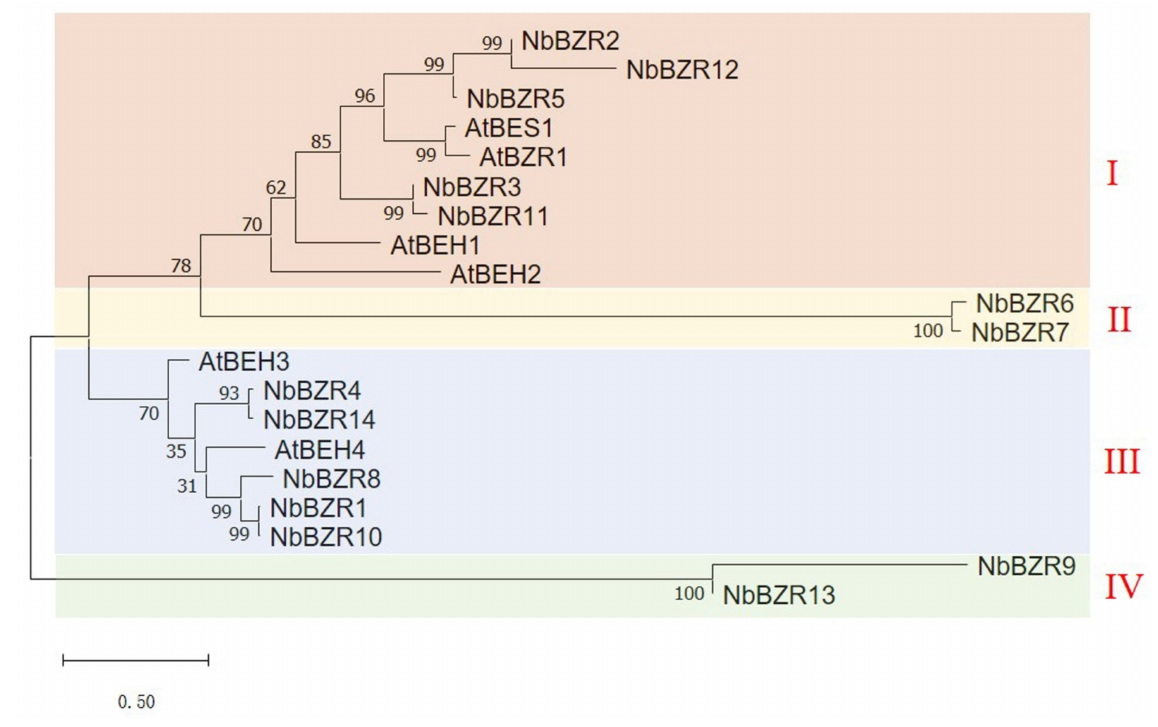
Figure 1. Phylogenetic tree of BZR transcription factors in N. benthamiana and A. thaliana. The phylogenetic tree was constructed using BZR amino acid sequences by the neighbor-joining method in MEGA X with 1000 bootstrap replicates. The phylogenetic tree was divided into four groups, which were shown in different colors, and identified by red Roman